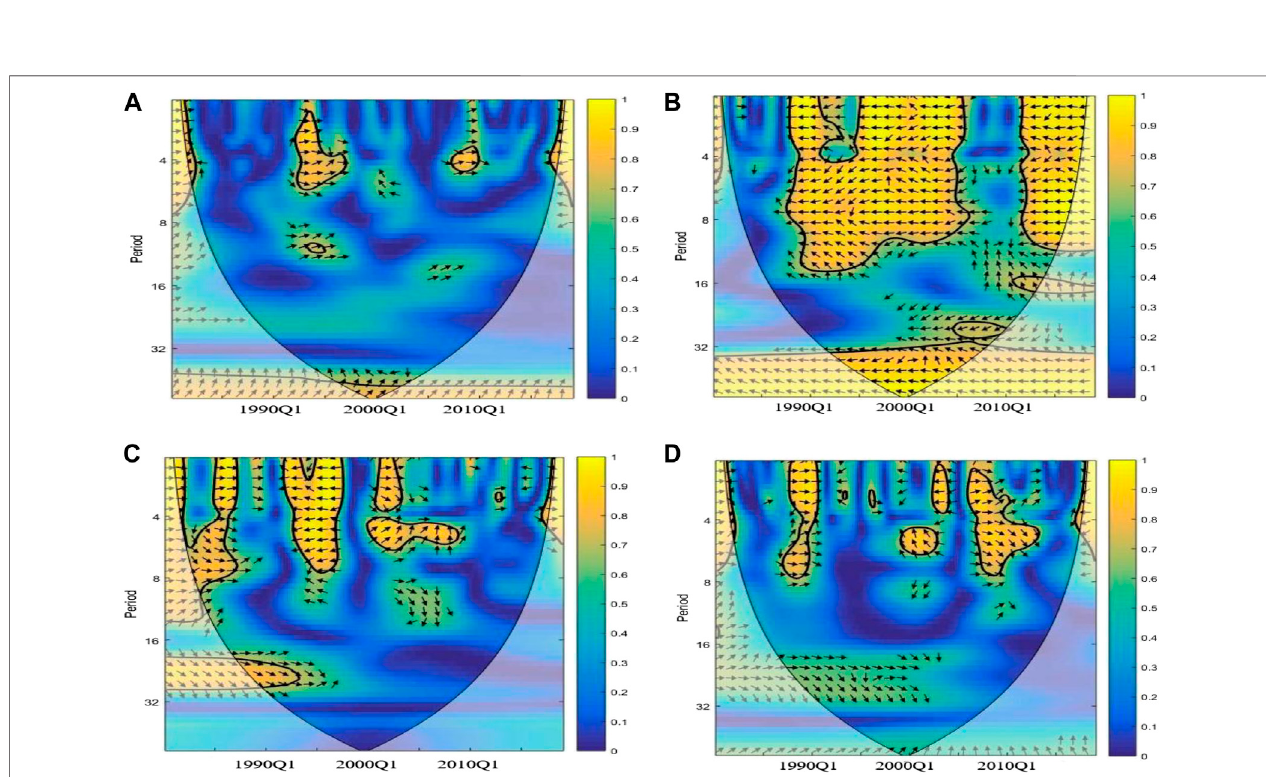
FIGURE 6 | (A) WTC between CO 2 and GDP. (B) WTC between CO 2 and REN. (C) WTC between CO 2 and TI. (D) WTC between CO 2 and GLO.